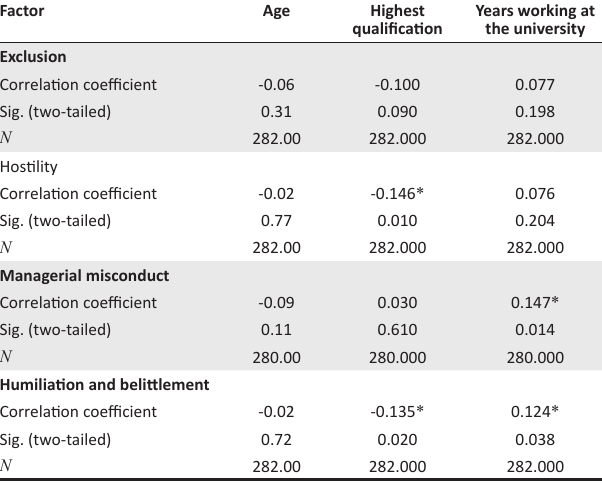
TABLE 4: Correlation of age, highest qualification and years working at the university with workplace